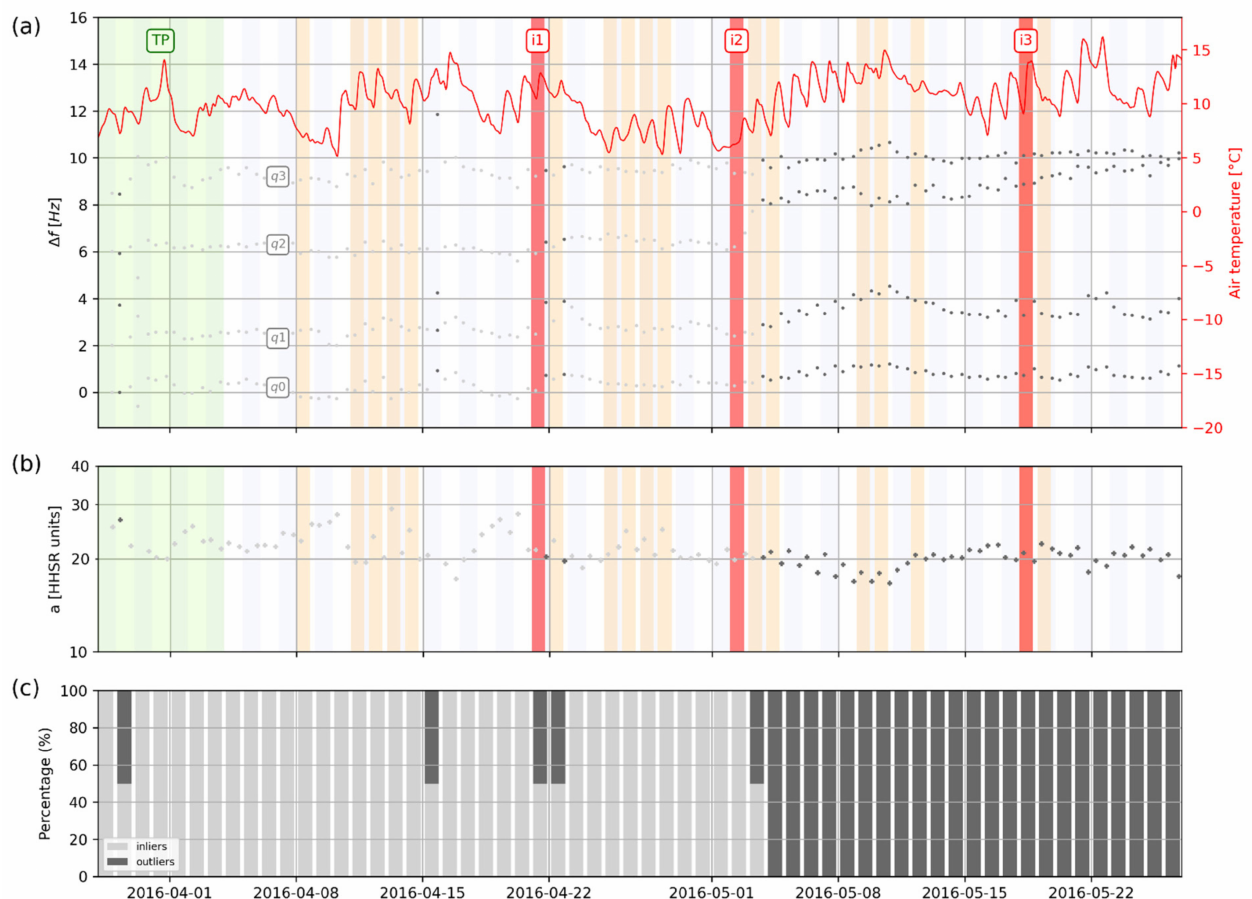
Figure 14. Novelty detection results performed on downsampled time series; dataset D2). Peak frequencies q 0 , q 1 , q 3 , q 5 shown in ( a ) have been arbitrarily shifted for the sake of easier comparison. HHSR amplitude a HHSR ( q 0 ) is shown in ( b ). Inlier data are shown in dark gray while outliers are shown in light grey. The training period (TP) at the beginning is underlined in green. Air temperature on-site is shown as red curve in ( a ). Reinforcement work stages are shown in the background: drilling days (light orange) and grout injection (red). ( c ) Respective percentage of inlier and outlier data in the detection